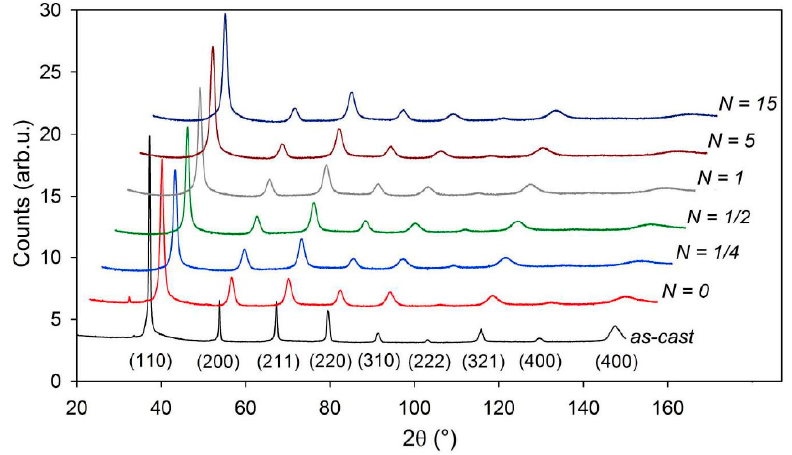
Figure 11. The development of XRD patterns for HfNbTaTiZr alloy during HPT straining for the various number of HPT revolutions N . Reprinted with permission from Ref. [144]. Copyright 2018 Elsevier.